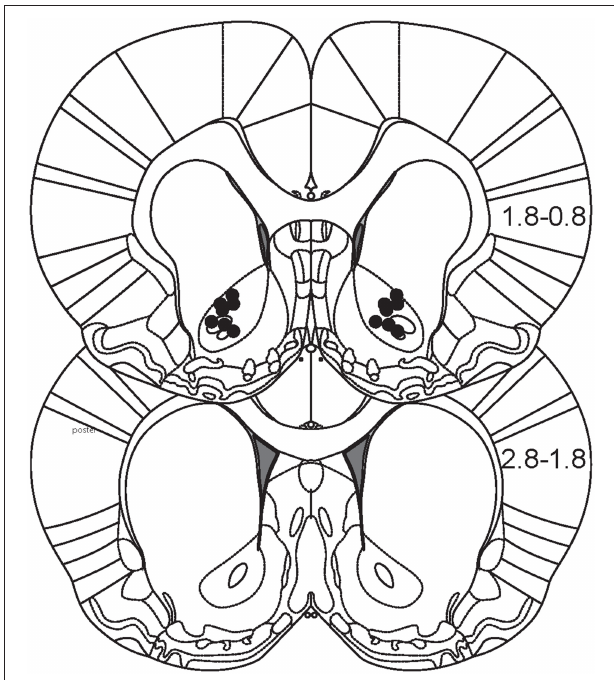
FIGURE 6 | Histological reconstruction of injection sites. Figure depicts two coronal sections of rat brain that encompass the majority of the anterior-posterior extent of the NAc (0.8–2.8mm anterior from Bregma). Black dots represent estimates of the location of microinjections for each